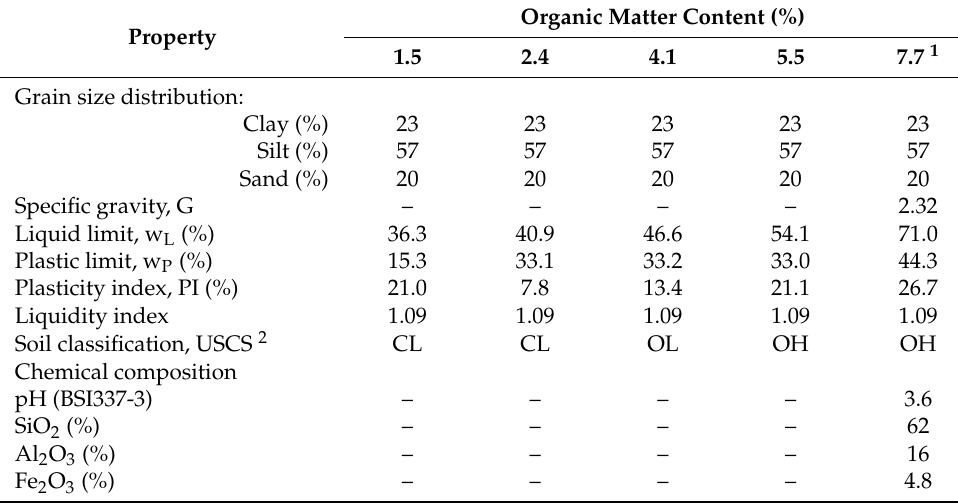
Table 2. Physical and chemical properties of the soils